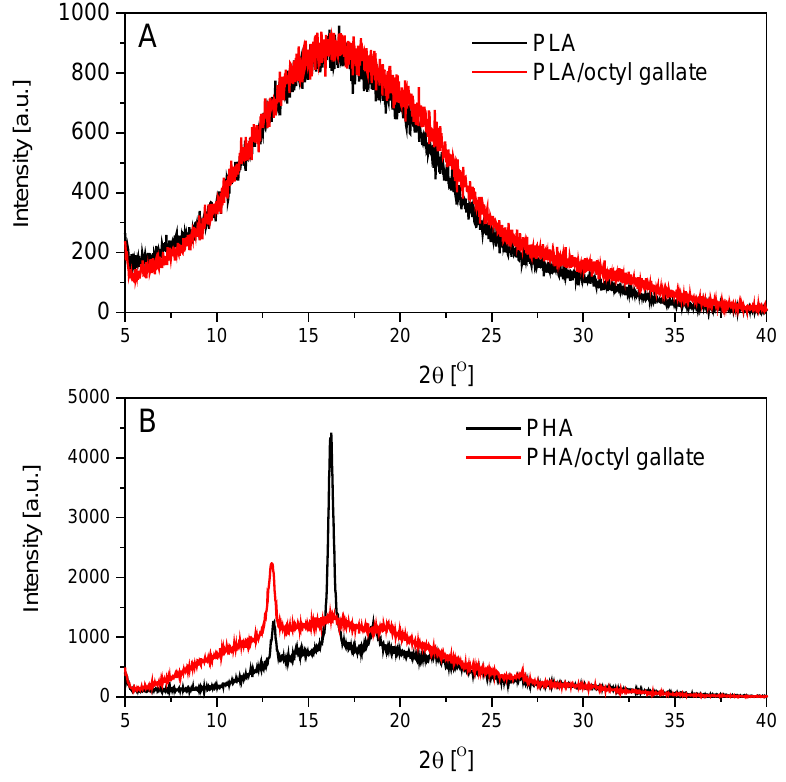
Figure 6. Wide-angle X-ray di ff raction (WAXD) spectra of PLA ( A ) and PHA ( B ) samples with gallates.